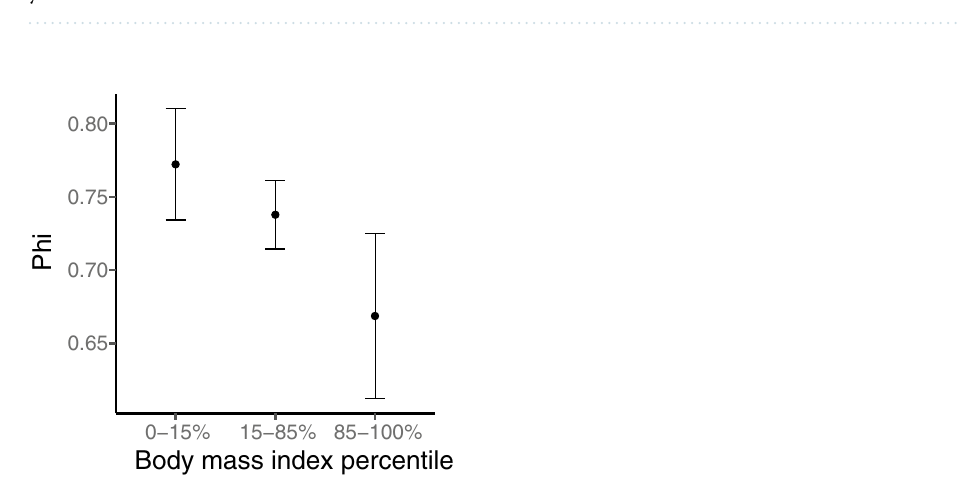
Figure 4. Apparent survival (Φ) estimates and standard error of nestling black sparrowhawks in relation to body condition percentile groups (group 1, 0–15%: 0.77 ± 0.04 SE; group 2, 15–50%: 0.74 ± 0.02 SE; group 3, 85–100%: 0.67 ± 0.06 SE). Re-sightings data was collected between 2001 and 2019 (N =